Question: Condense the content of this figure into a single sentence.
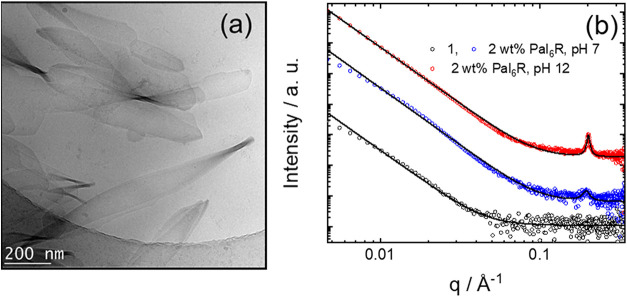
Answer: Self-assembly of Pal 6 R at pH 7. (a) Cryo-TEM image from 1 wt % solution, (b) SAXS data under the conditions indicated; open symbols: measured data; solid lines: fitted intensity profiles as described in the text (fit parameters in SI Table S2 ). For ease of visualization, data has been vertically shifted.